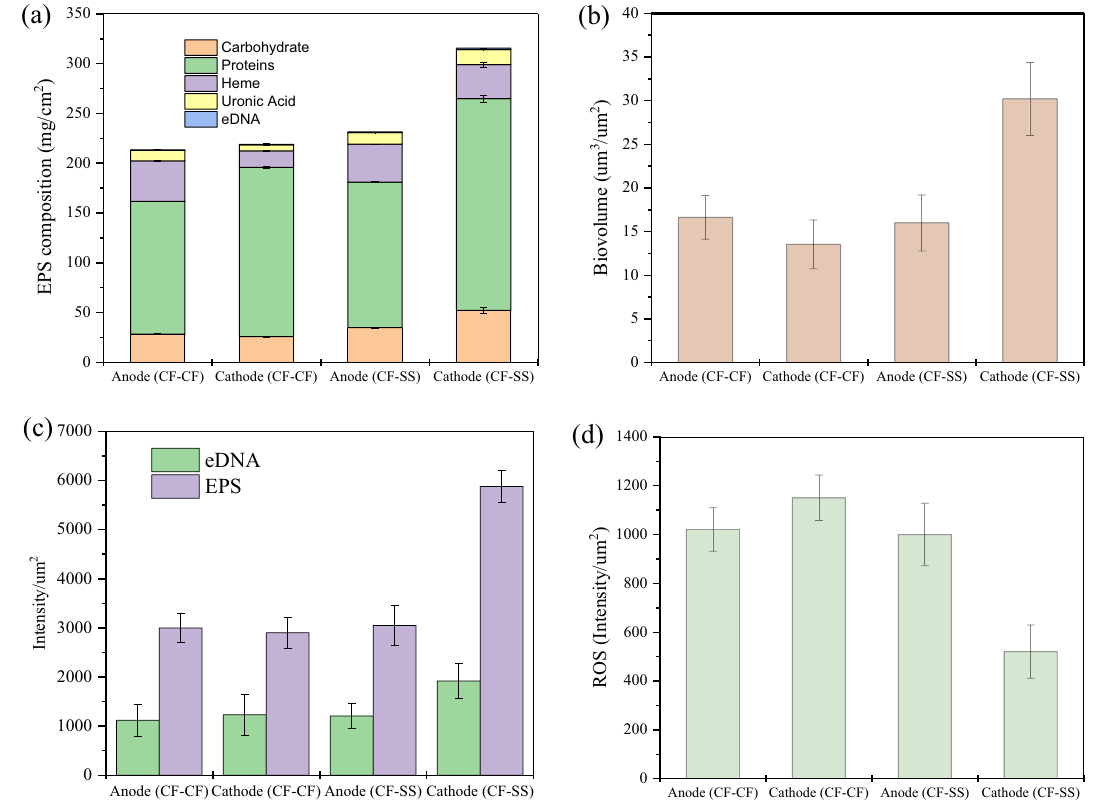
Figure 2. EPS levels in biofilms ( a ), EPS quantitative analysis using CLSM; biovolume ( b ), and fluorescence intensity ( c ), and reactive oxygen species (ROS) intensities ( d ) of CF–CF and CF–SS reactors. Note. The error bars indicate the standard deviation of three replicates (n =